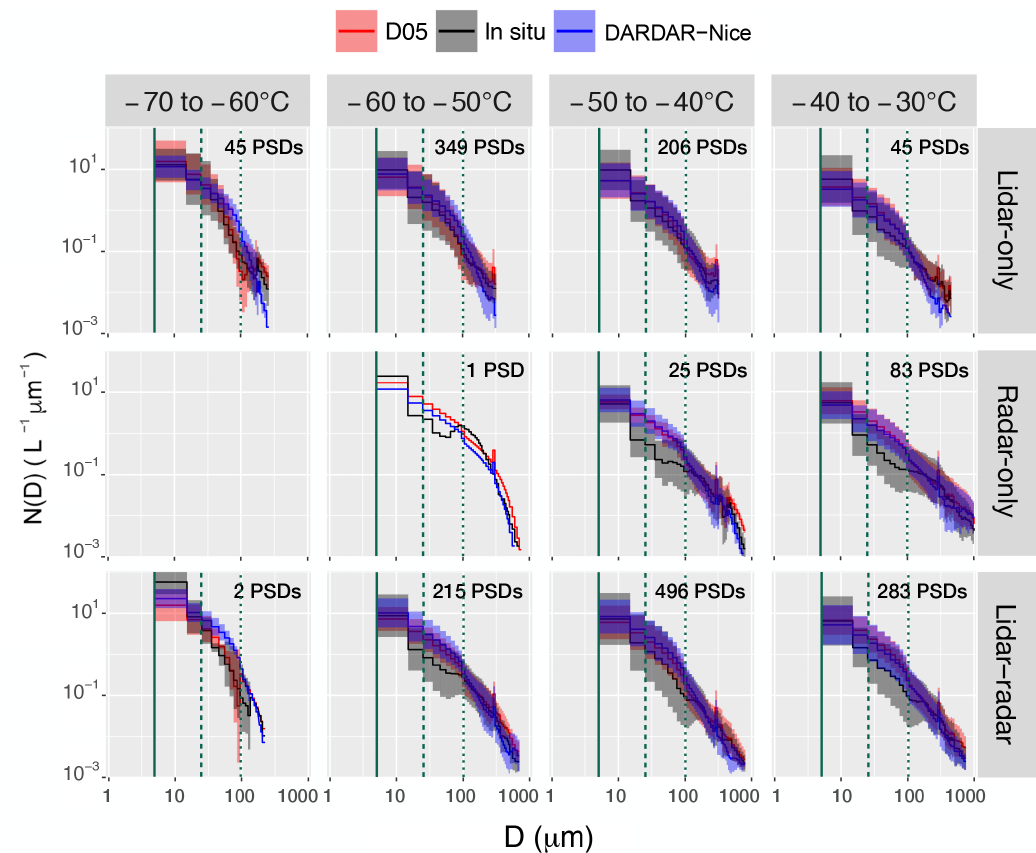
Figure 3. Similar to Fig. 1 but for SPARTICUS flights coincident with the A-Train overpass. PSDs estimated on the basis of DARDAR IWC and N ∗ retrievals (i.e., corresponding to the DARDAR-Nice N i ) are shown in blue. All PSDs are averaged per temperature bin (columns) 0 and by instrumental conditions met during DARDAR retrievals